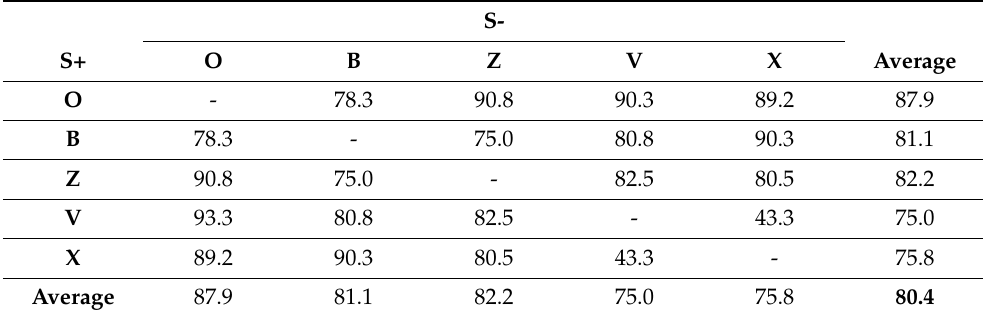
Figure 6. Accuracy (% correct) of discrimination between each pair of letters in the transfer test (See Methods 2-4-5). Discrimination was difficult for pairs O and B, B and Z, and V and X. Only the four mares completed this phase. Table 2. Dissimilarity matrix of the 5 letters for 4 horses. The value is the accuracy (% correct) in the discrimination task in the transfer tests. S+ means the positive stimulus while S- means the negative stimulus. Touching S+ was rewarded in each pair. In the present study, the upper right of the matrix is the real result of discrimination learning. The lower left of the matrix is the mirror image to calculate the perceived dissimilarity (perceived distance) of two letters. The present study did not test the reversed situation of changing the role of S+ and S- in each pair. Letter O was always S+, letter X was always S-, and letters B, Z, and V were in